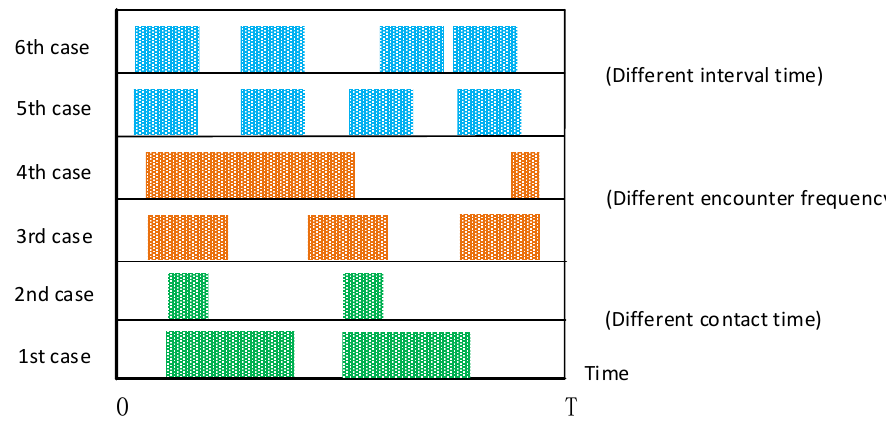
Figure 8. Different scenarios encountered assuming two